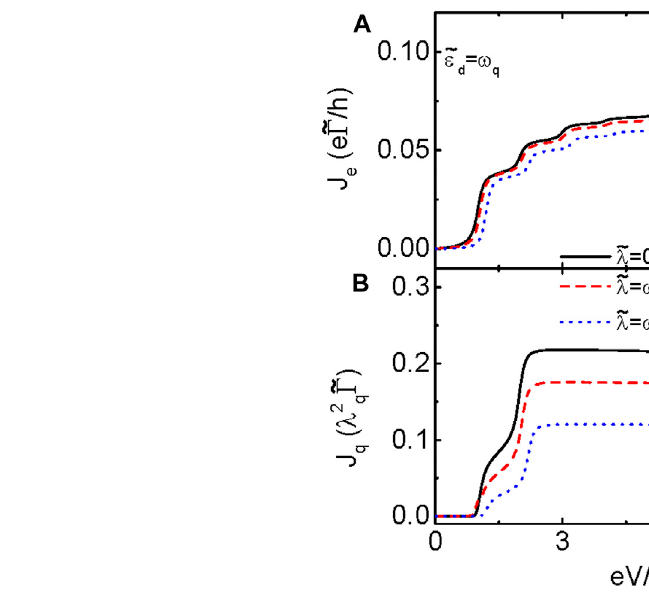
̃ (cid:1) ω q /4. Other parameters are as in Figure 2 .